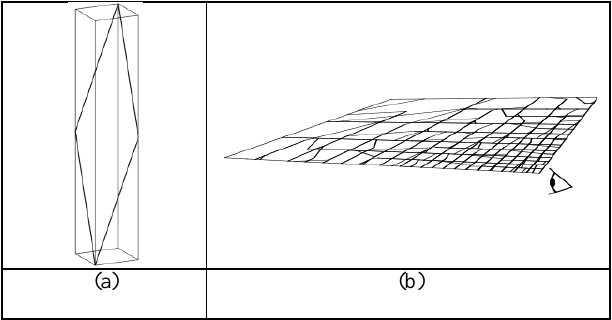
Figure 2. (a) Taking an arbitrary cross section in a 3D (2D space + 1D scale) cube leads to (b) a derived 2D representation that has mixed scale: close to the observer much detail is shown, while further away less detail is obtained. For 4D models (3D space + 1D scale), a similar operation can be